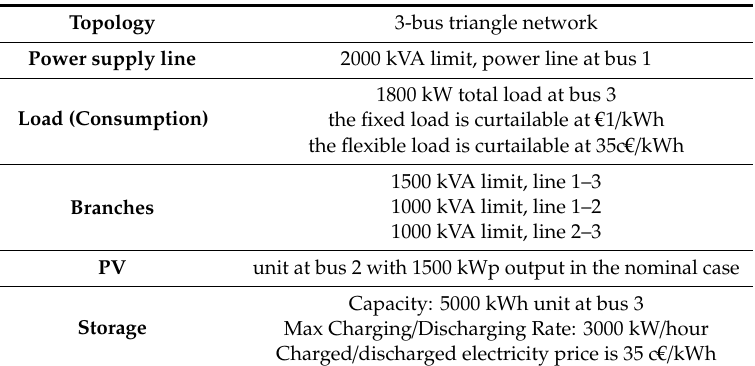
Table 1. Data of the studied community.